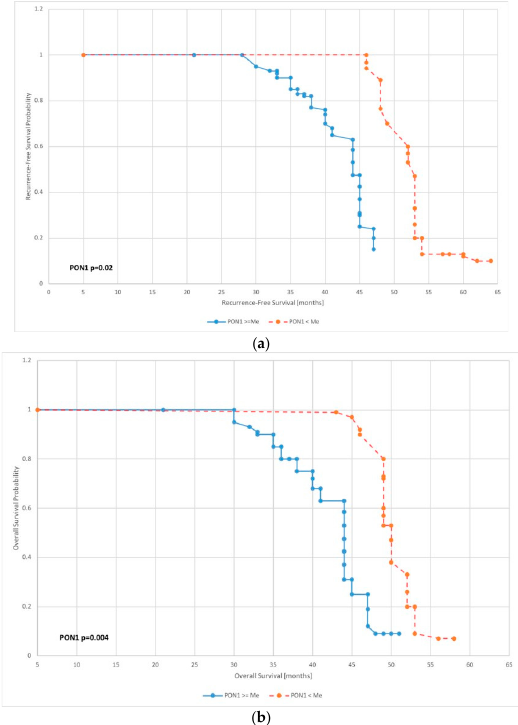
Figure 3. Kaplan–Meier recurrence-free survival curve ( a ) and overall survival curve ( b ) for endometrial cancer patients based on serum PON 1 level.